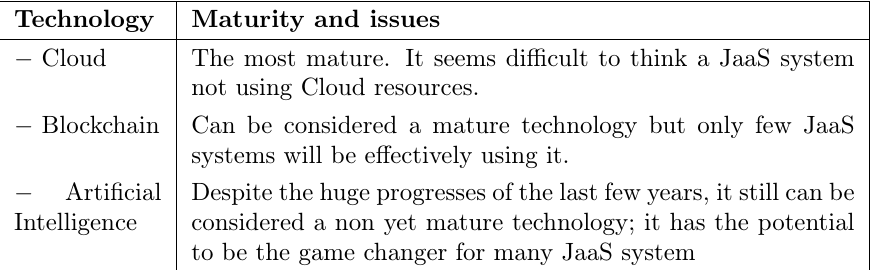
Table 3. Key points from this section: JaaS’ technologies